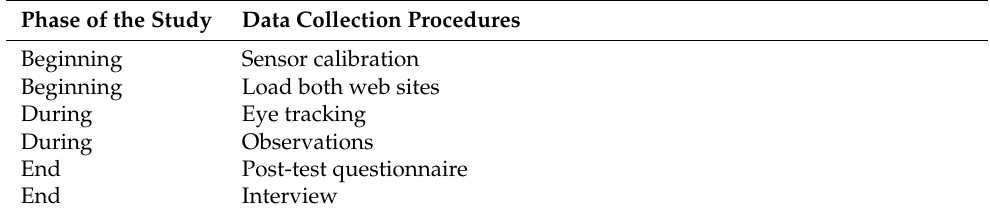
Table 4. Data collection